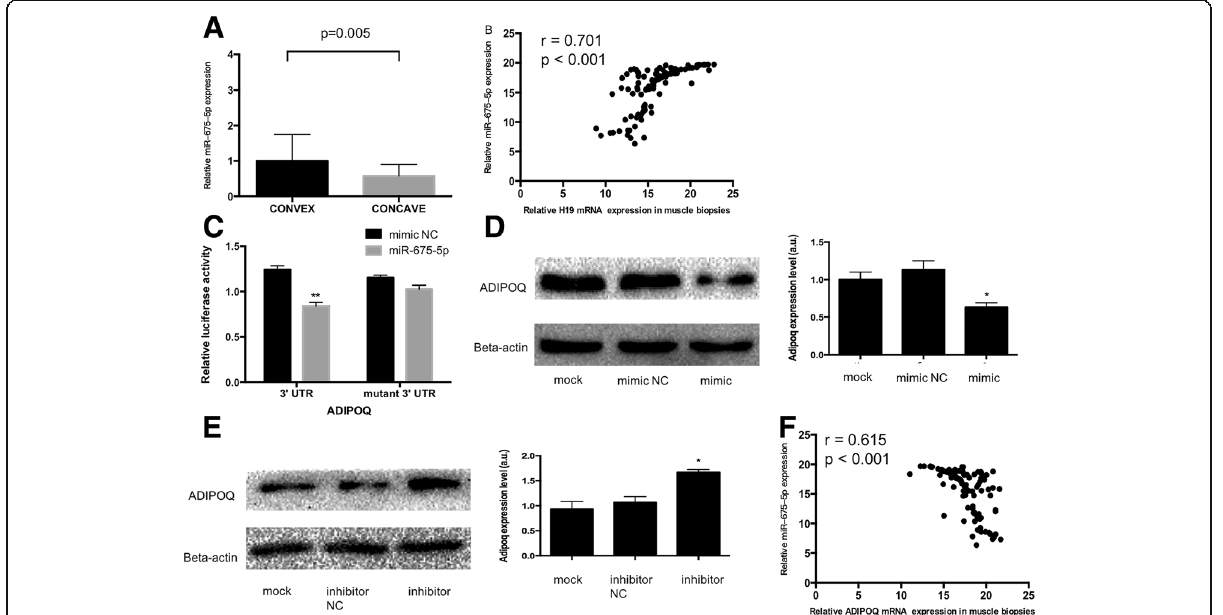
Fig. 5 miR-675-5p directly targeted the 3 ’ UTR of ADIPOQ. a Tissue samples were processed for assessment of expression of miR-675-5p as described in Materials and Methods. miR-675-5p showed a significantly higher expression in convex-sided muscle tissue in AIS patients ( n = 60). Results are expressed as mean±SEM, and the relative expression of miR-675-5p is represented as fold change related to the convex side. b Correlation analysis identified that the expression level of miR-675-5p in muscle tissues was positively correlated with that of H19 in AIS patients ( n = 60). c HEK293T cells were co-transfected with miR-675-5p mimics/mimic NC and plasmid with wild type or mutant luc-3 ’ UTR of ADIPOQ. Luciferase values were normalized to those of Renilla luciferase and expressed as fold-induction relative to the basal activity. Co-transfection of luc-3 ’ UTR but not mutant miR-675-5p luc-3 ’ UTR with a miR-675-5p mimic significantly impairs luciferase expression in HEK293T cells. The experiments were performed three times. Results are expressed as mean±SEM. **, P <0.01 versus luc-3 ’ UTR. For ( d , e ), HSkMSC cells were subjected to transfection and differentiation induction as indicated. After 72 h, total cellular proteins were extracted from harvested cells. Levels of ADIPOQ protein were assessed with Western blot using anti-ADIPOQ antibody, as described in Materials and Methods. Left panels illustrate the autoradiographs of representative immunoblots; right panels show densitometric analysis of the immunoblot data (normalized to beta-actin). The experiments were performed three times. Results are expressed as mean±SEM. *, P <0.05 versus NC/Mock. f Correlation analysis identified that the expression level of miR-675-5p in muscle tissue samples was negatively correlated with that of ADIPOQ mRNA in AIS patients ( n